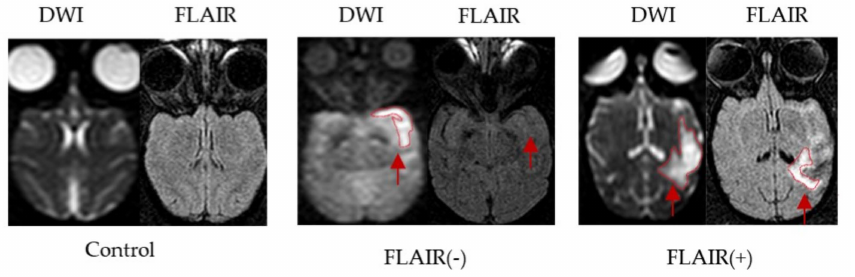
Figure 2. Brain MRI images of the MCAO model in cynomolgus macaques. Representative images of infarction lesions on DWI and FLAIR in cynomolgus macaque brains after MCAO (red